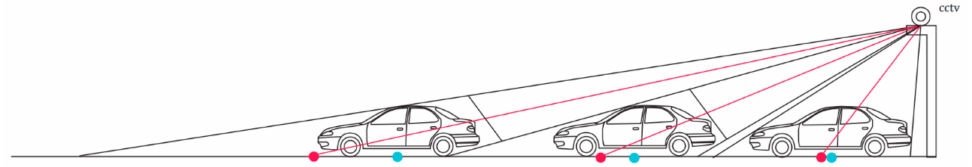
Figure 7. The center position of the moving vehicle resulting from the geometric displacement of the